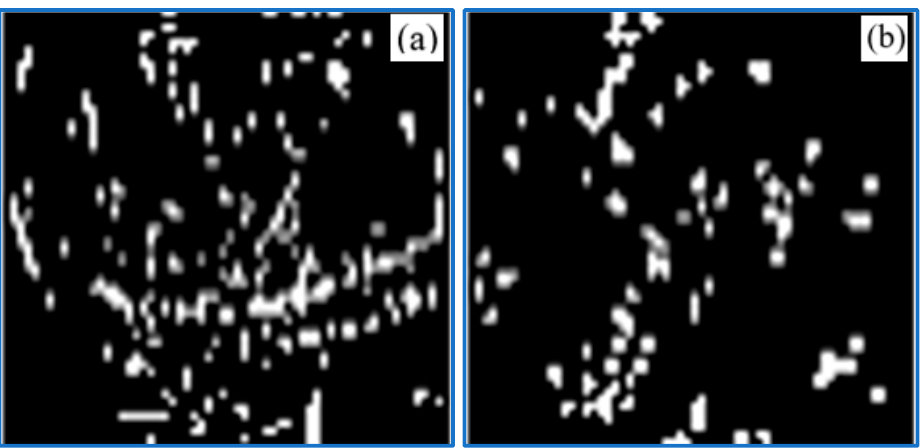
Figure 12. Scattering configuration of CFUs of E. Coli before ( a ) and after ( b ) plasma treatment. Only the plasma-exposed area is shown in the photograph. Processes 2019 , 7 , x FOR PEER REVIEW